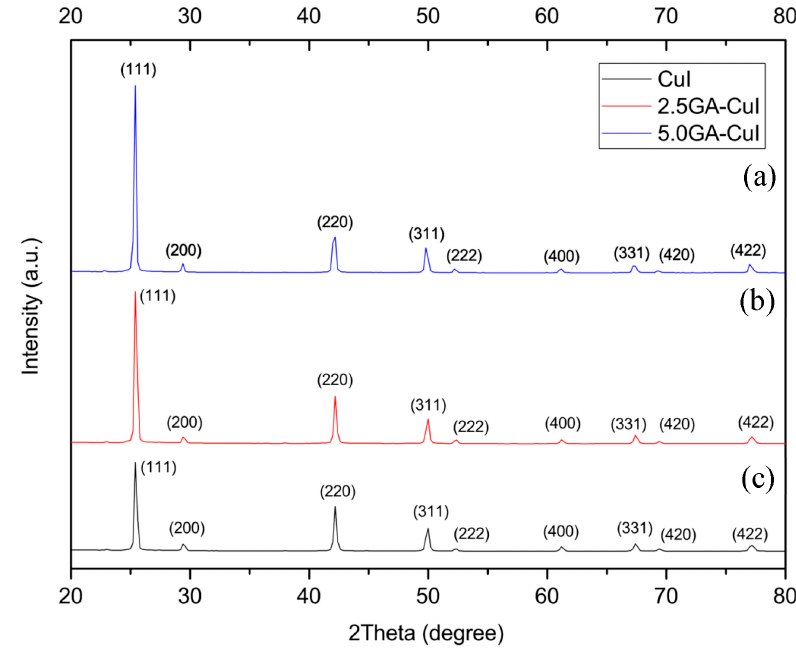
Figure 1. XRD patterns of synthesized nanoparticles (a) 5.0GA-CuI NPs (b) 2.5GA-CuI NPs and (c) CuI NPs